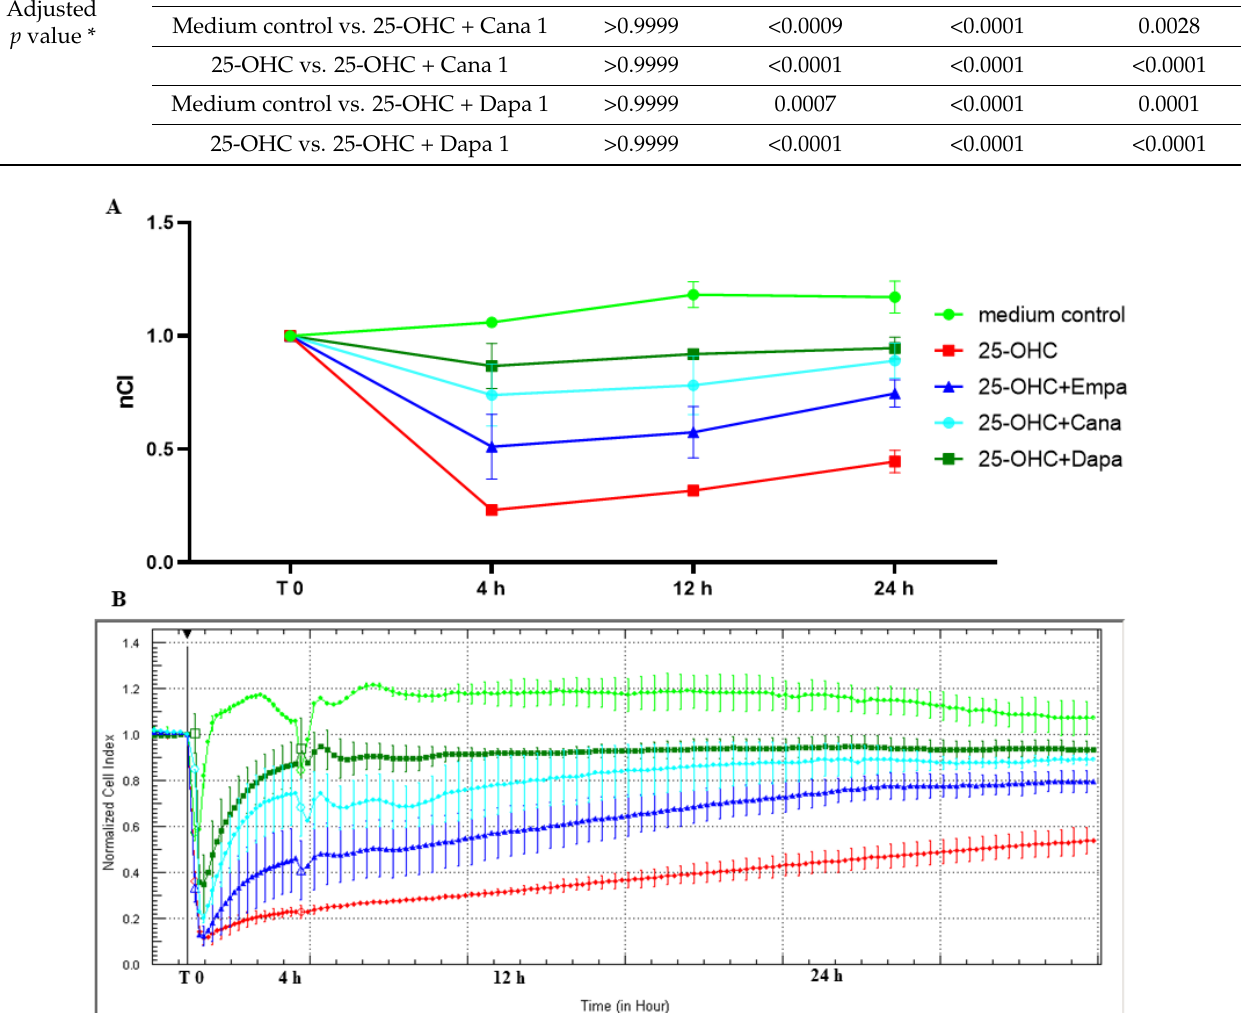
Figure 2. ( A ) The effect of SGLT2 inhibitors empagliflozin (1 µM), canagliflozin (1 µM), and dapagliflozin (1 µM) on the integrity of HUVECs that are pre-stimulated with 25-OHC for 4 h. Data collected by real-time cell electric impedance sensing system. ( B ) Representative plot from the real-time cell electric impedance sensing system, each line represents the mean of three wells of each condition.